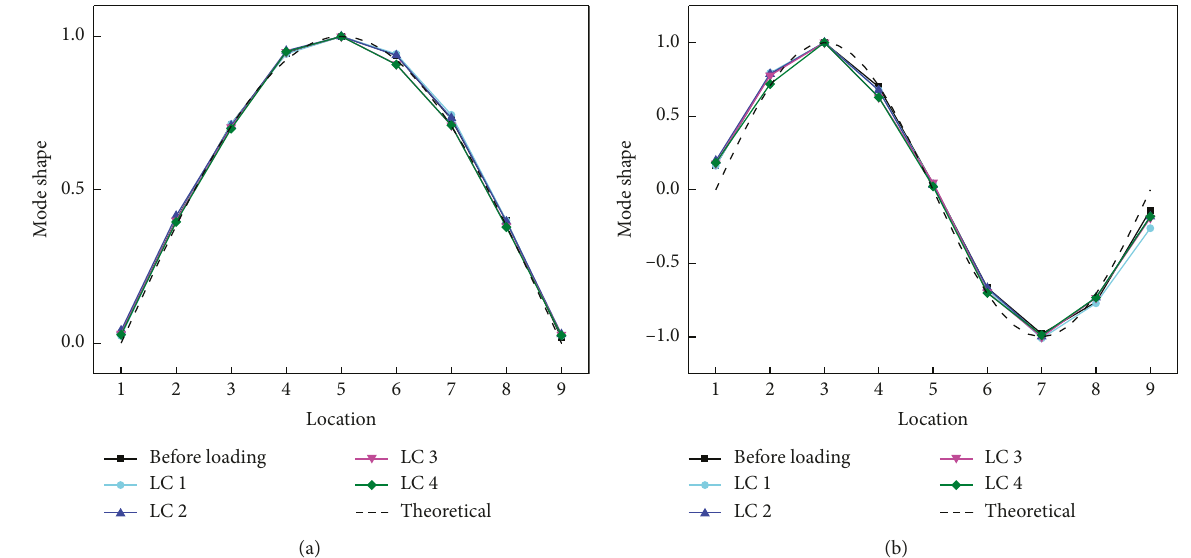
Figure 11: Test natural frequencies and mode shapes for girder Z1. (a) Mode 1. (b) Mode Table 6: Designed stiffness and initial stiffness of test girders (10 10 N · m 2 ). Girder